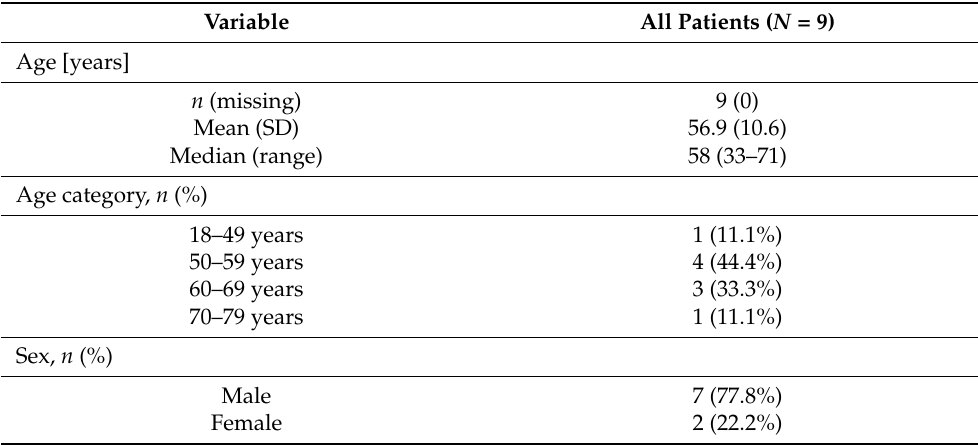
Table 1. Demographic characteristics (all